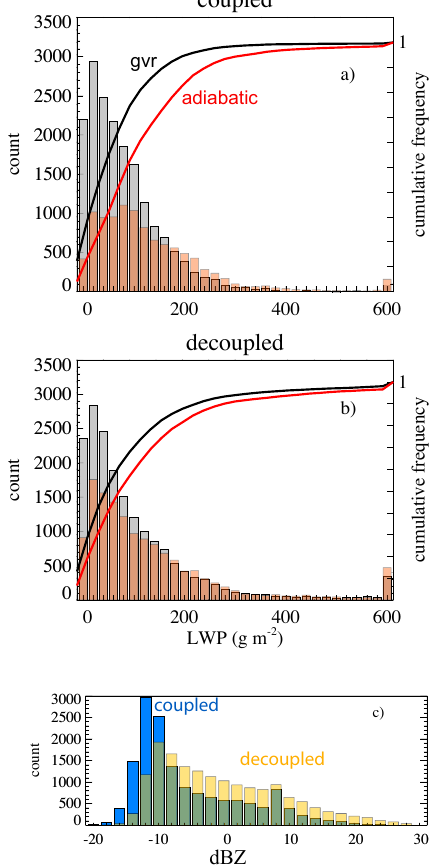
Fig. 13. Distributions of GVR-retrieved (black) and adiabatic (red) LWPs from the subcloud legs of thirteen research flights for (a) coupled ( Z CB -LCL < 125m) and (b) decoupled ( Z CB -LCL > 125m) conditions. LWP bins of 20gm − 2 , only samples with known cloud bases and lifting condensation levels were considered. (c) the count distributions of the column-maximum radar reflectivities for cou- pled and decoupled conditions.